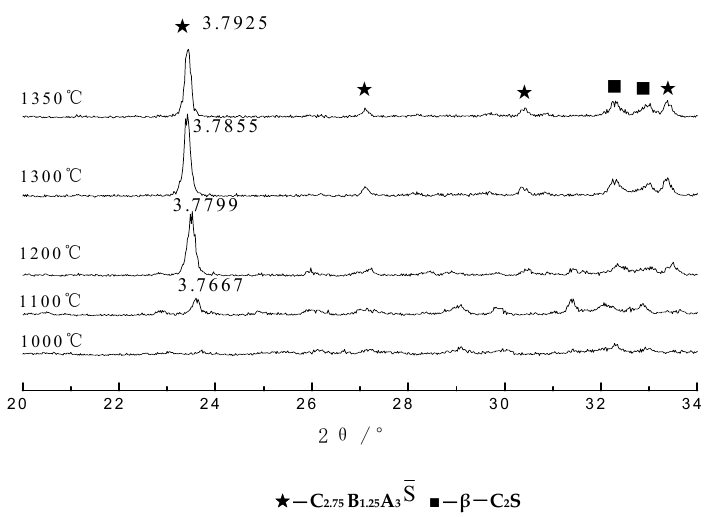
Figure 5. Partial enlargement of XRD of sample F3 at different temperatures.